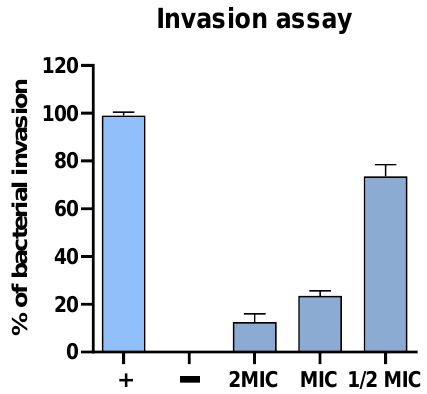
Figure 5. Invasion assay of S. aureus in HaCaT cells. HaCaT were treated with different concentrations of Hylin-a1 and then infected with S. aureus . (+) Cells treated with S. aureus bacteria; ( − ) cells not treated; (2MIC): cells treated with Hylin-a1 (12.5 µ M); (MIC): cells treated with Hylin-a1 (6.25 µ M); ( 1 / 2 MIC): cells treated with Hylin-a1 (3.125 µ M). Data represent mean values + standard errors of the means of duplicate experiments.